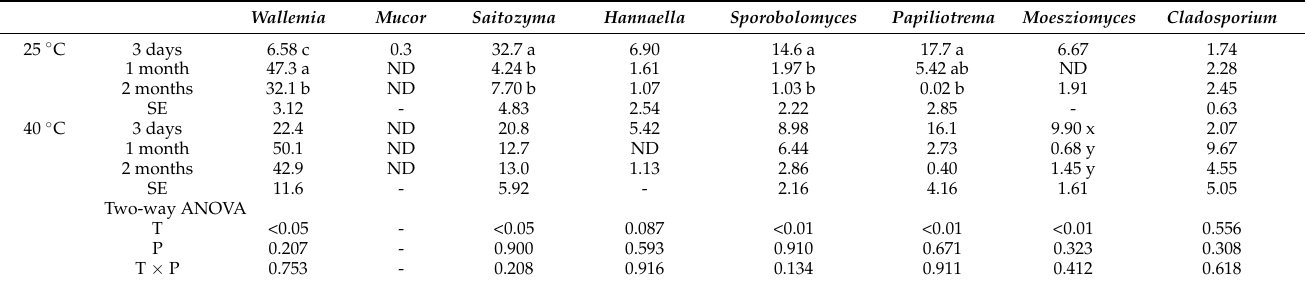
Table 5. Relative abundances (%) of the eight most abundant fungal genera in direct-cut guinea grass silage stored at 25 and 40 ◦ C for 3 days, 1 month, and 2 months.